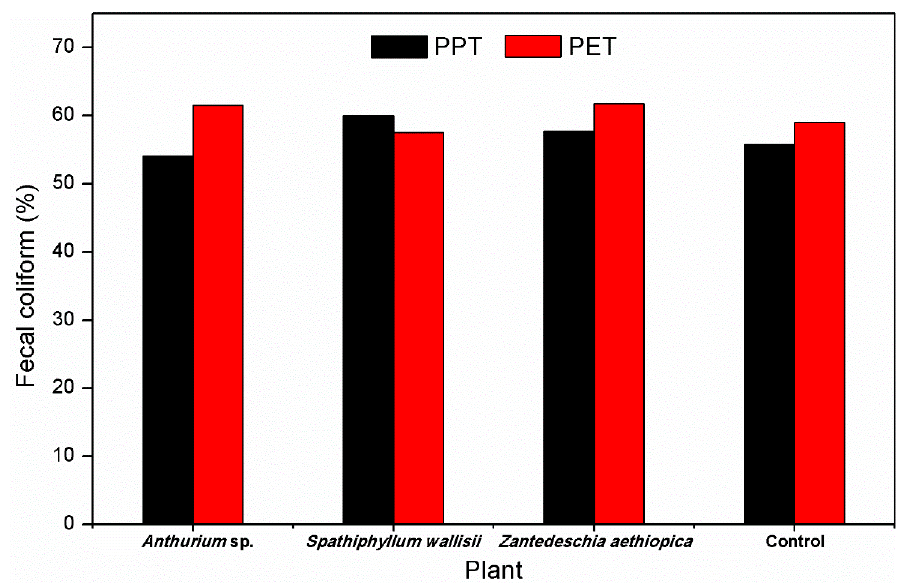
Figure 7. Fecal coliform removal in influent and effluent of microcosms.